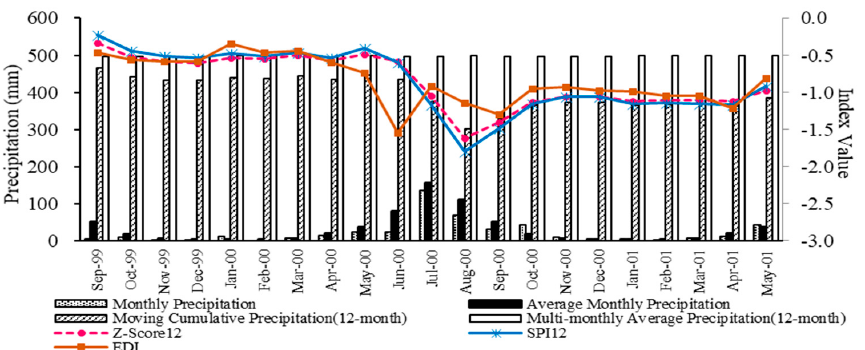
Figure 7. Changes of precipitation and drought indices for 12-month timestep in Keshan station from September 1999 to May 2001.